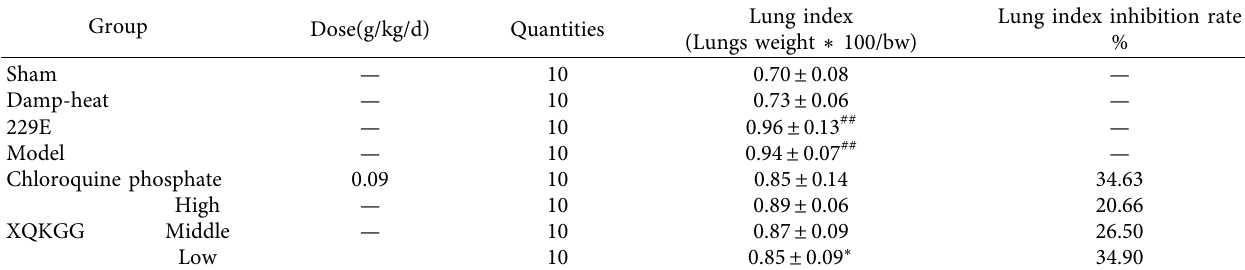
Table 1: Comparison of the lung index in groups.